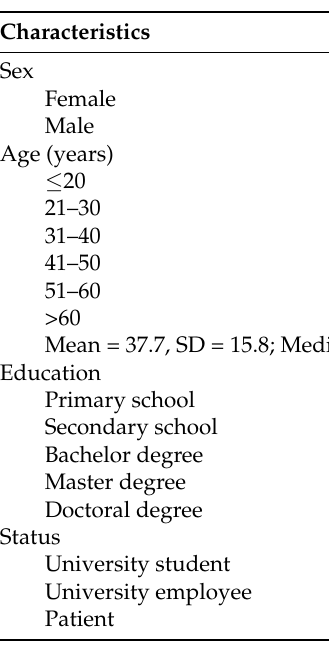
Table 1. Demographic characteristics of participants ( n =